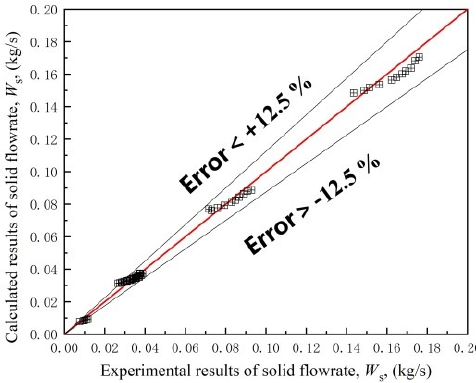
Figure 8. Comparison of experimental and theoretical solid flow rates.